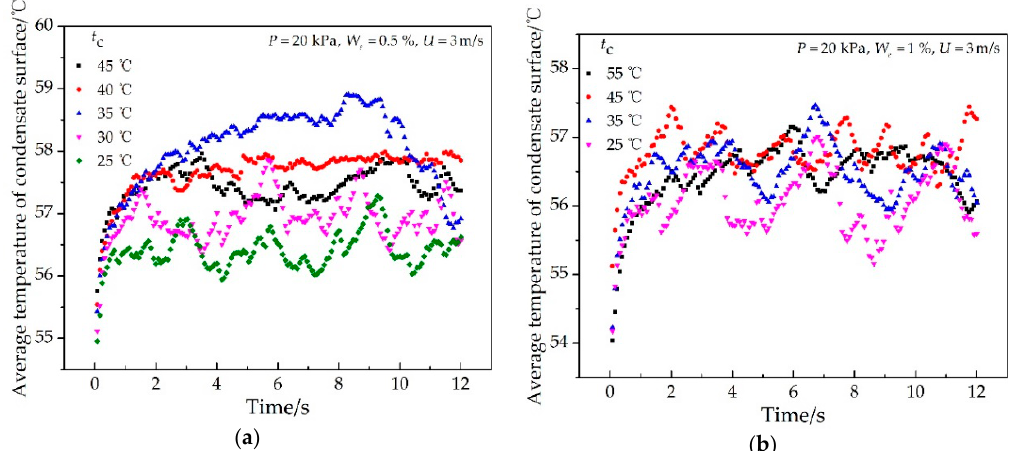
Figure 11. Effect of the impinging cooling water temperature on the average temperature of the condensate surface at different times with the experimental conditions of ( a ) P = 20 kPa, W e = 0.5%, U = 3 m / s; ( b ) P = 20 kPa, W e = 1%, U = 3 m / s.